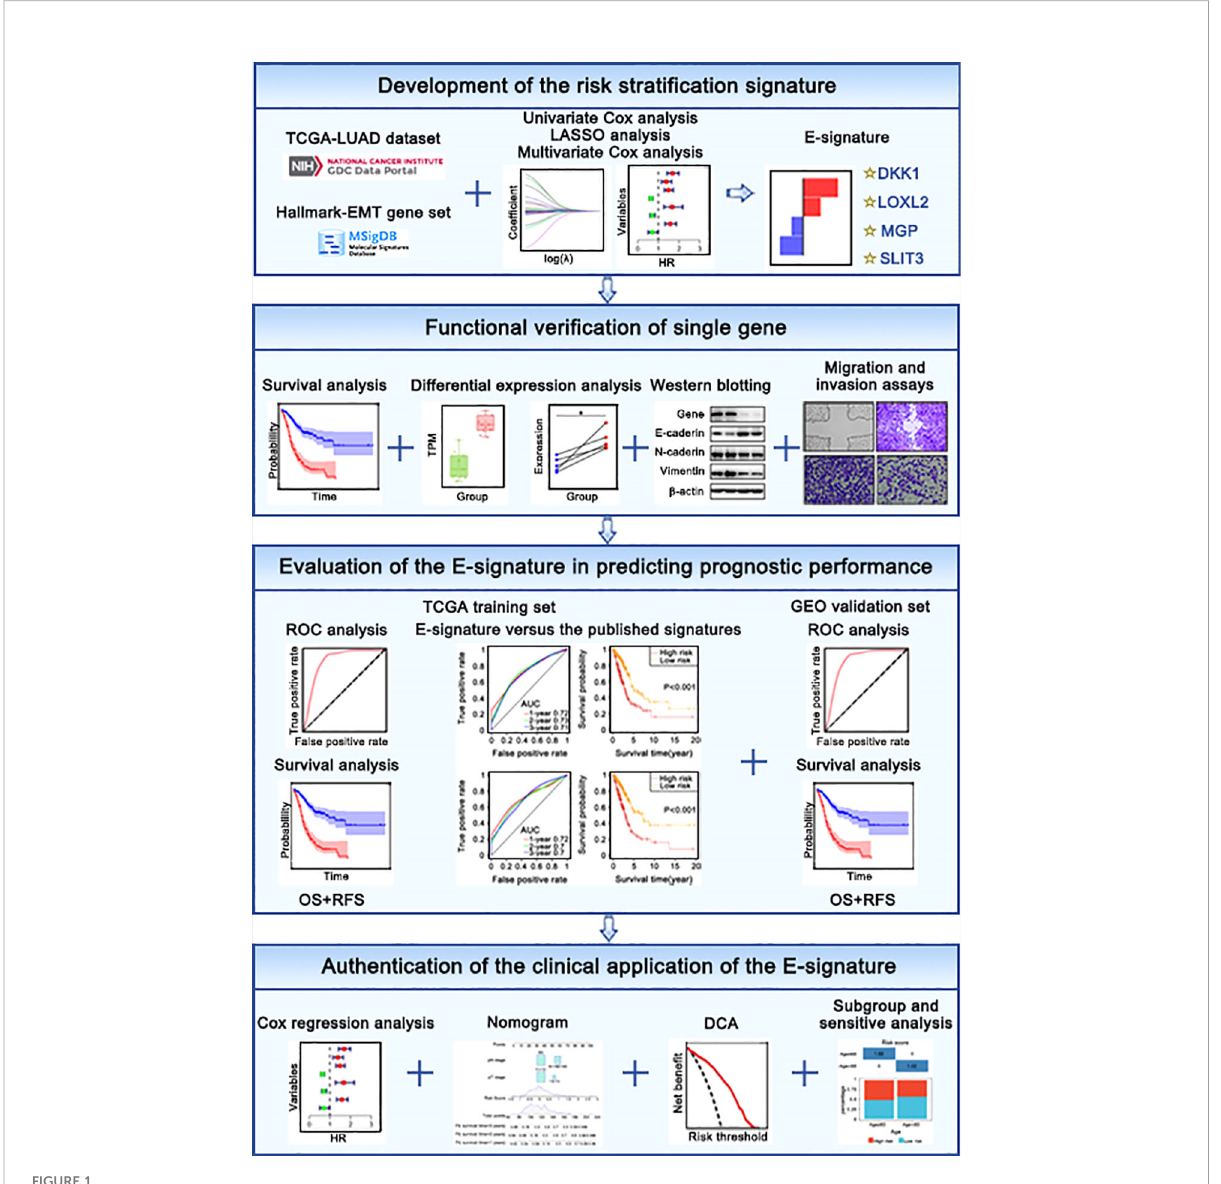
FIGURE 1 The fl ow chart in our